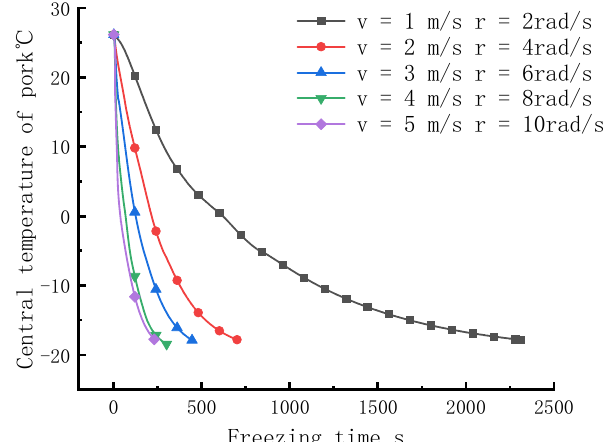
Figure 14. Increase the central temperature and time curve of pork with the speed of load basket and the flow rate of refrigerant.